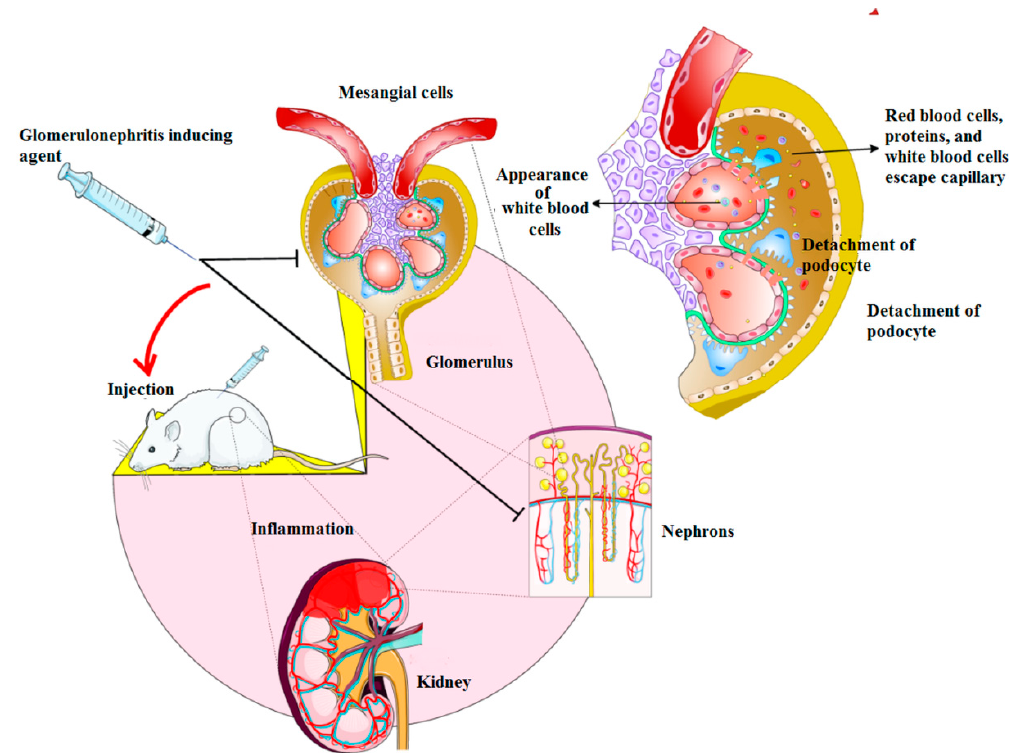
Figure 3. The protective role of endothelial progenitor cells (EPC)-derived nanovesicles in an experimental model of glomerulonephritis. These nanovesicles can inhibit mesangial cell proliferation, inflammatory response and proteinuria in the induced glomerulonephritis in vivo.